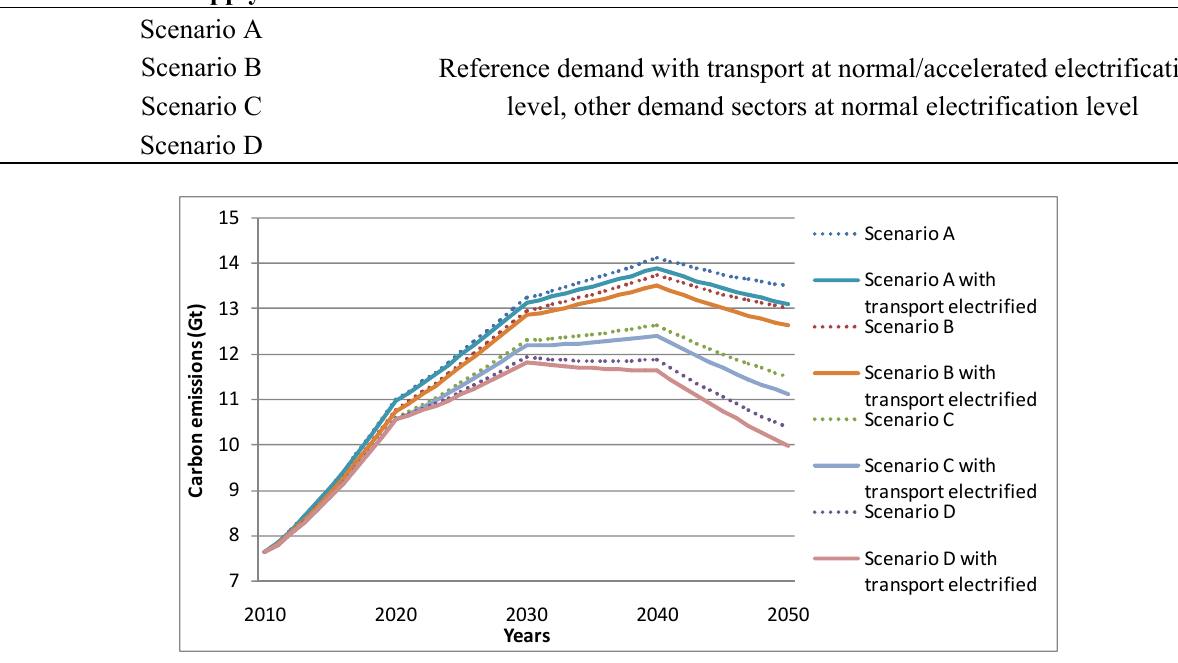
Figure 12. Carbon emission trends at different transport electrification